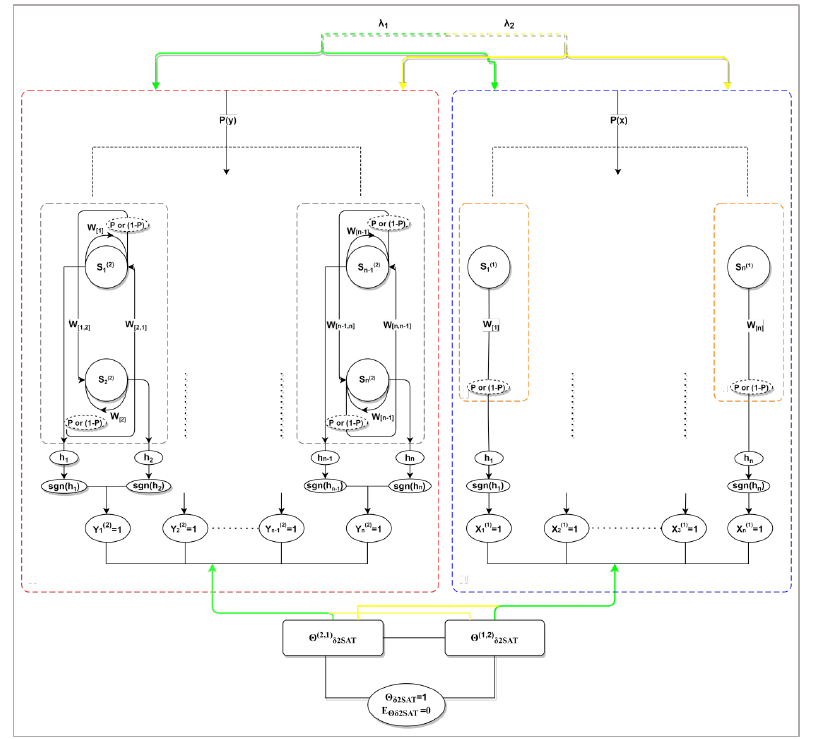
Figure 2. Schematic diagram of 2 DHNN SAT